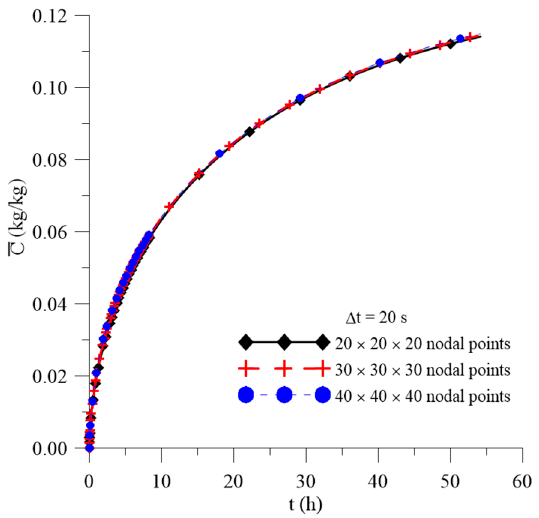
Figure 6. Transient behavior of average free solute concentration for different meshes. Polymers 2019 , 11 , 1847